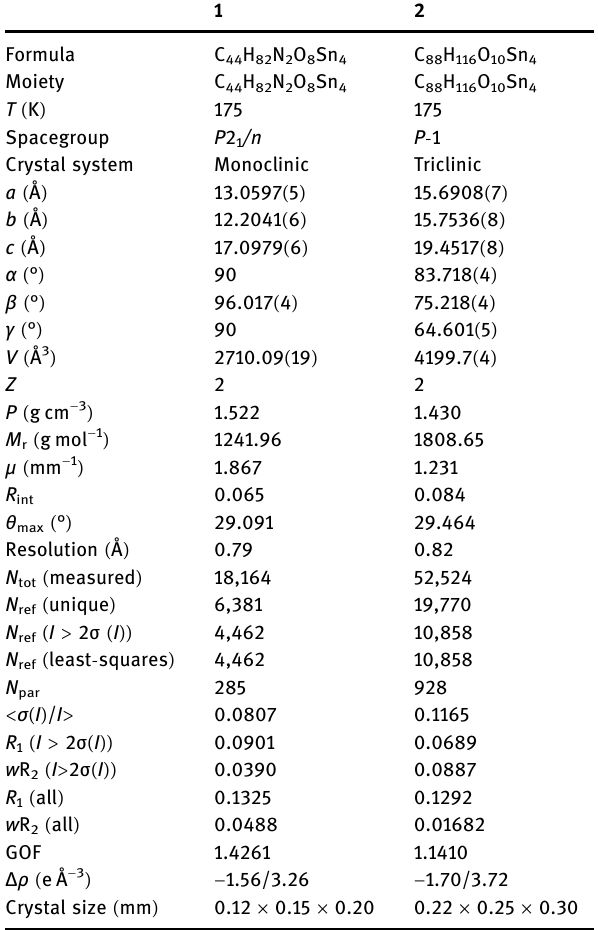
Table 1: Crystal data and structure re fi nement of 1 and